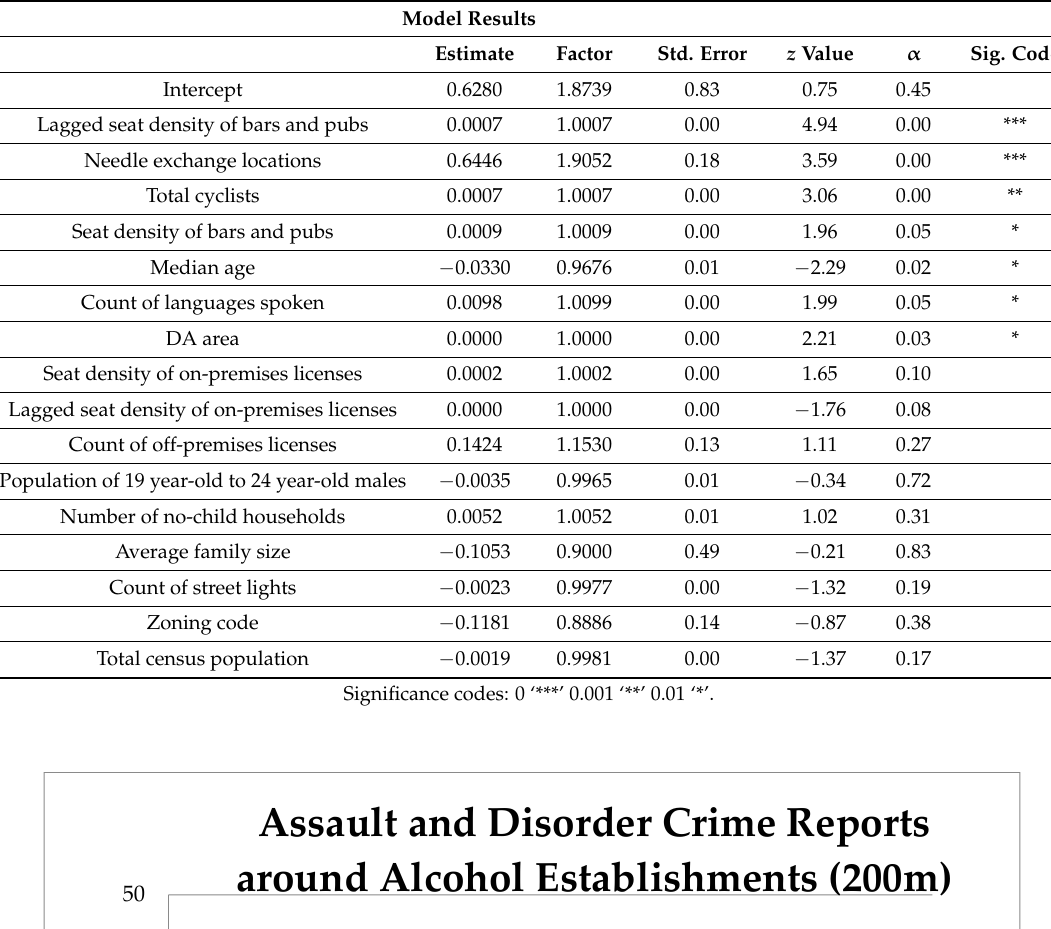
Table 2. Model estimates from the Poisson spatial lag model. Coefficients were evaluated at the p < 0.05 level.